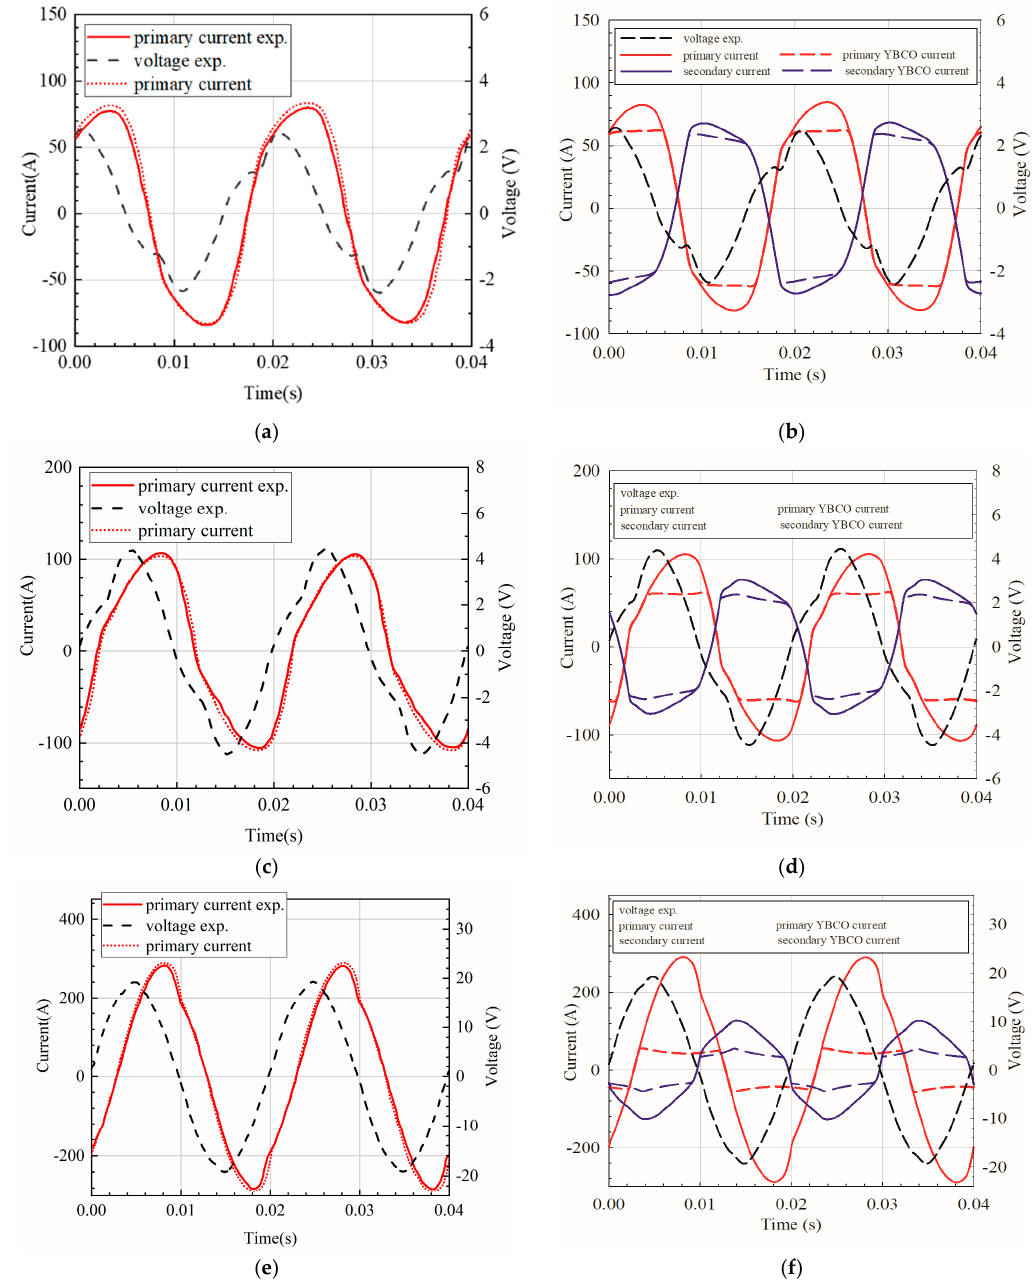
Figure 15. Comparison of experimental (left) and simulation (right) results of voltage and current curves. ( a ) Comparison of primary current curve between experimental and simulation under voltage magnitude of 2.6 V, ( b ) overall simulation current under voltage magnitude of 2.6 V, ( c ) comparison of primary current curve between experimental and simulation under voltage magnitude of 4.5 V, ( d ) overall simulation current under voltage magnitude of 4.5 V, ( e ) comparison of primary current curve between experimental and simulation under voltage magnitude of 19.5 V, and ( f ) overall simulation current under voltage magnitude of 19.5